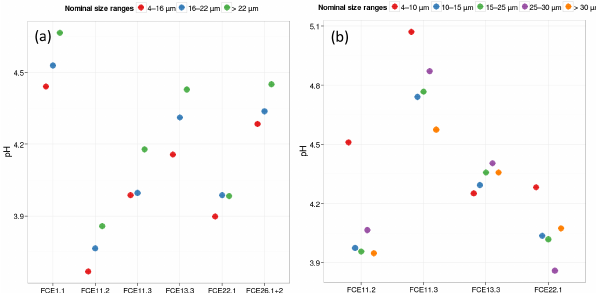
Figure 8. Mean pH values per event, calculated from volume- weighted mean concentrations of H + from (a) three-stage cloud water collector and (b) five-stage